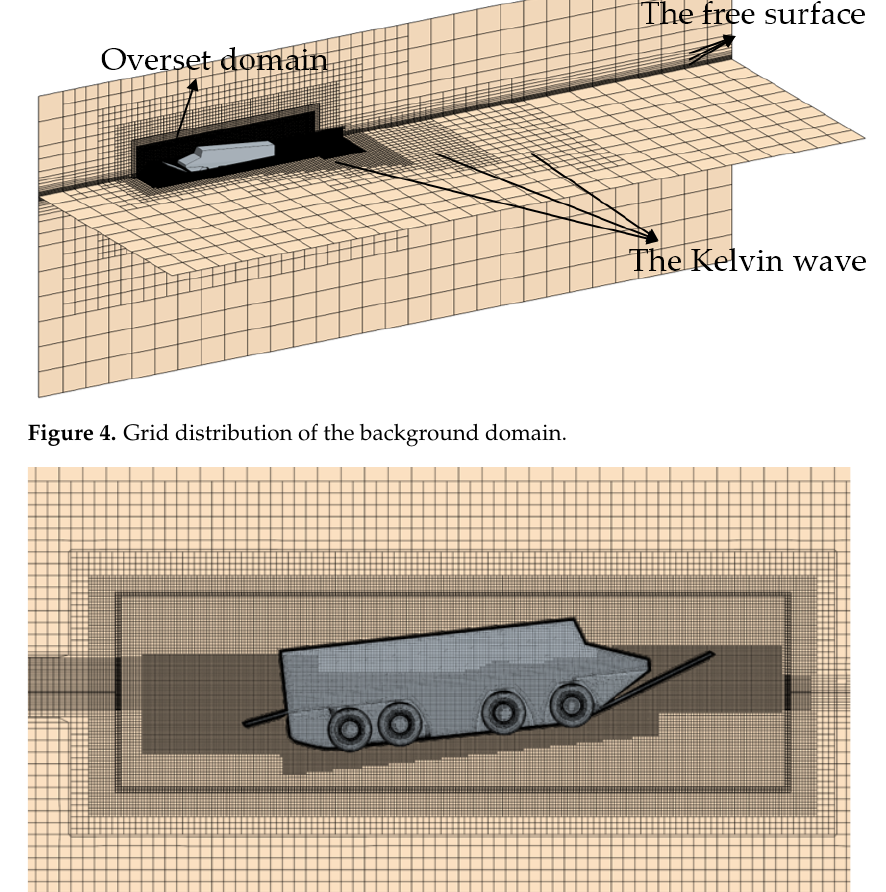
Figure 4. Grid distribution of the background domain.